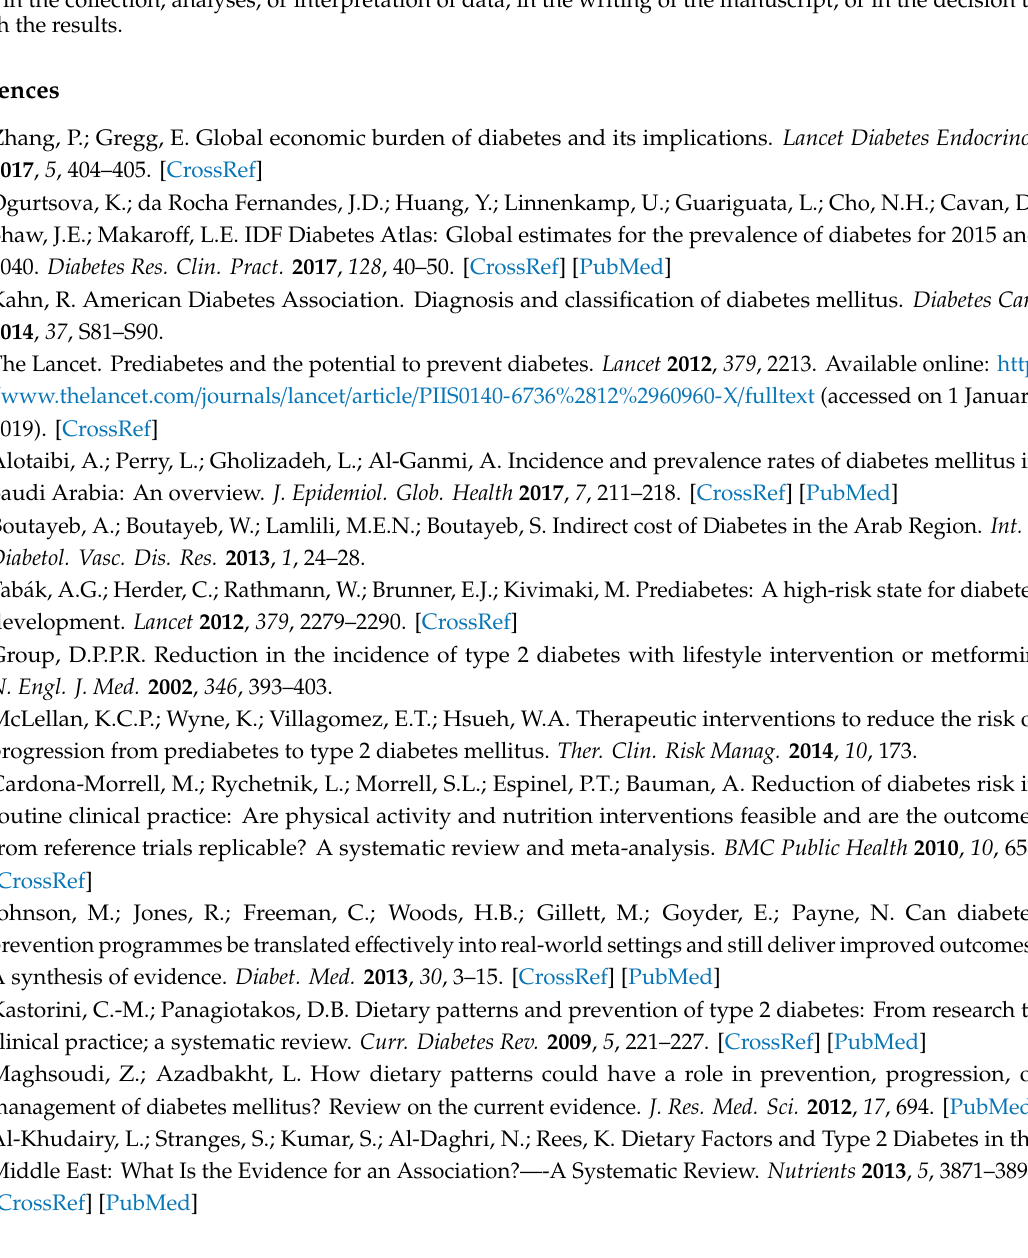
Table S1: Other anthropometric and biochemical characteristics of study groups at baseline, Table S2: Other biochemical characteristics of study groups overtime, Table S3: Dietary preferences of study groups’